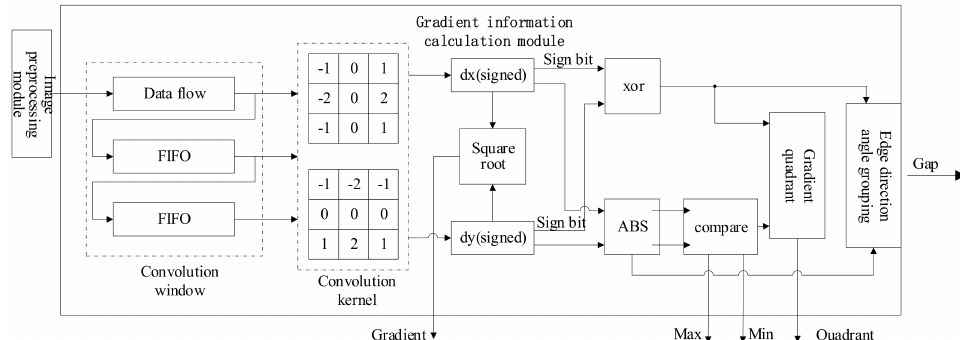
Figure 6. Circuit diagram of gradient information calculation module.